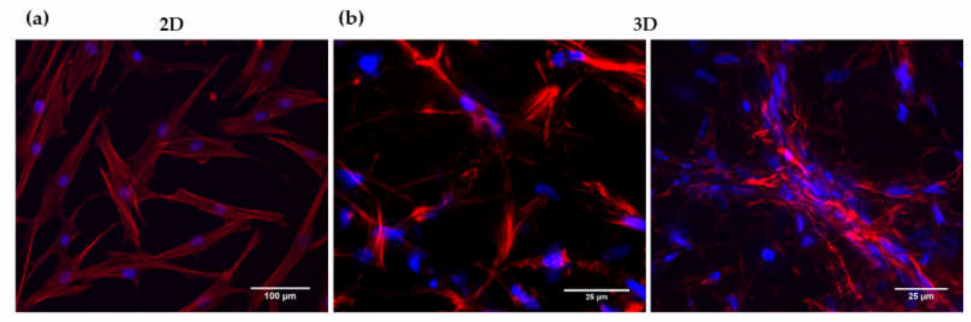
Figure 4. DAPI / Phalloidin staining of HFDPC in ( a ) 2D and ( b ) 3D cultures.